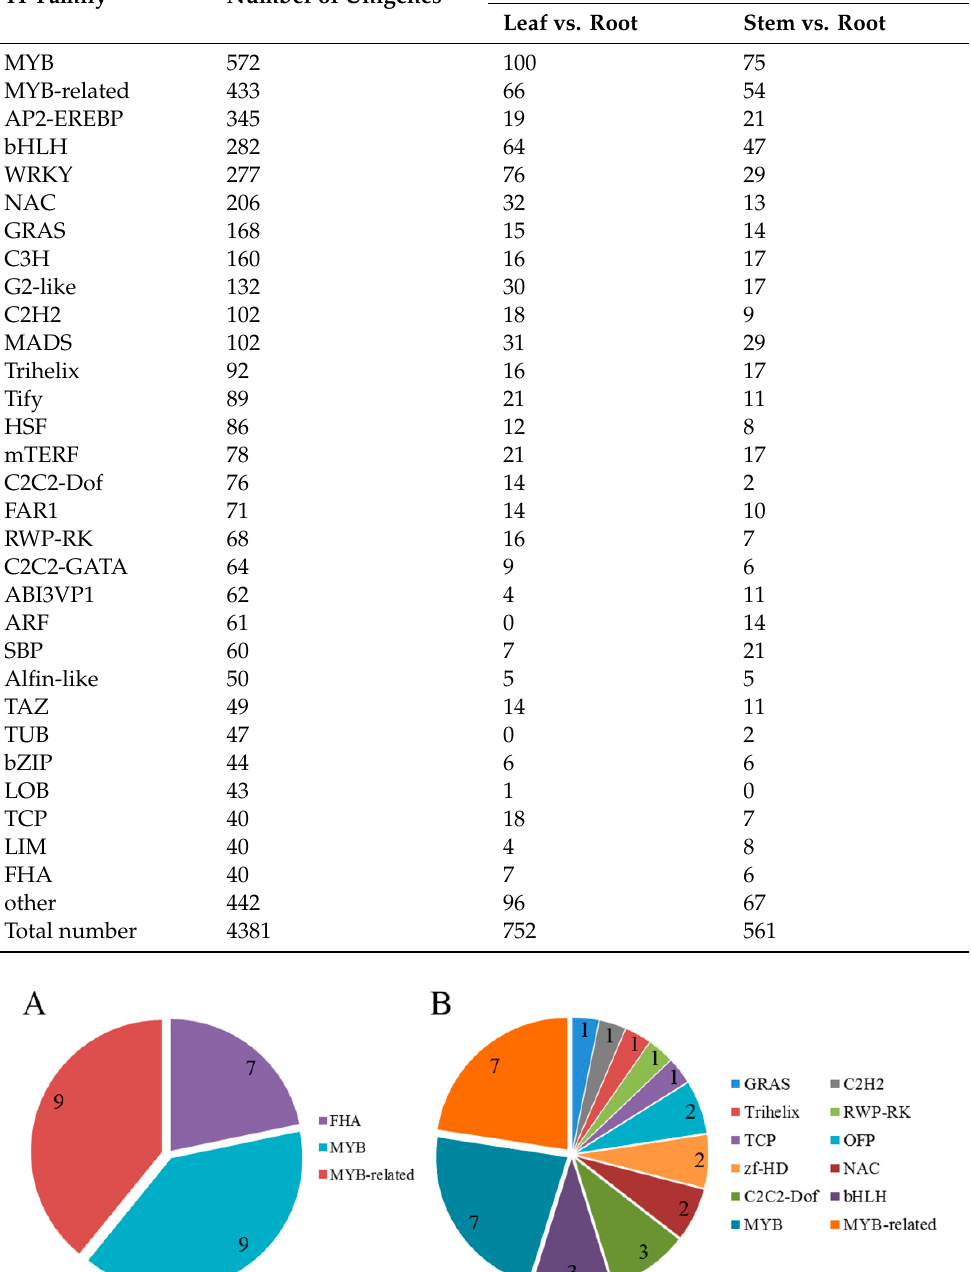
Figure 8. Transcription factor (TF) families in the metabolic pathway. ( A ) TF families in the metabolism of terpenoids and polyketides. ( B ) TF families in the biosynthesis of other secondary metabolites. Table 4. Classification and number of TF families identified in the DEGs database of C. chinense.